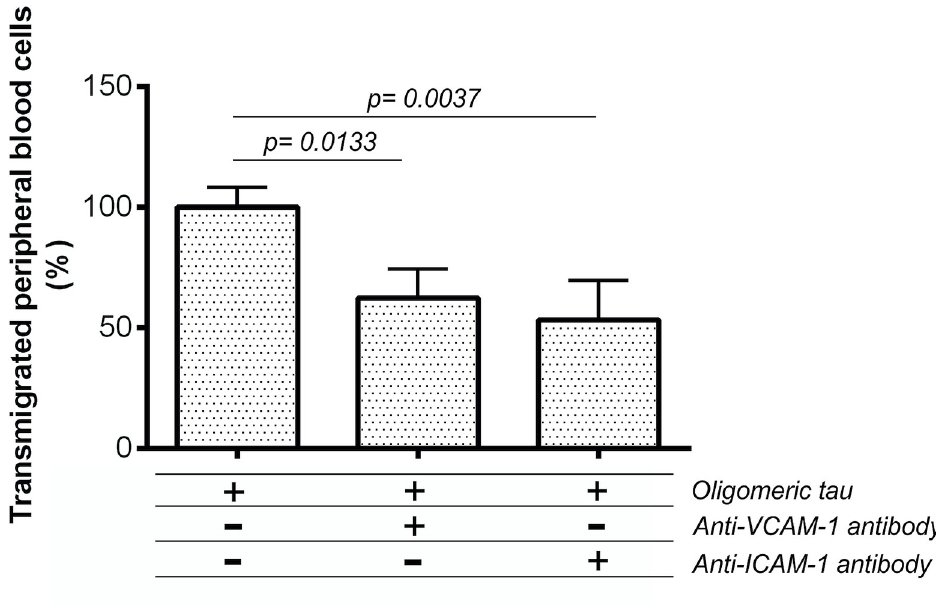
Fig 10. Involvement of adhesion molecules ICAM-1 and VCAM-1 in tau-mediated transendothelial migration of PB-MoM. We test the effect of antibodies ICAM-1 and VCAM-1 on transendothelial migration of PB-MoM cells across in vitro BBB model. The graph showed a decline in amount-percentage of transmigrated cells after antibody inhibition. Data are means ± SD of individual experiments run in six plicate, n = 30. Differences at p < 0.05 were accepted as statistically